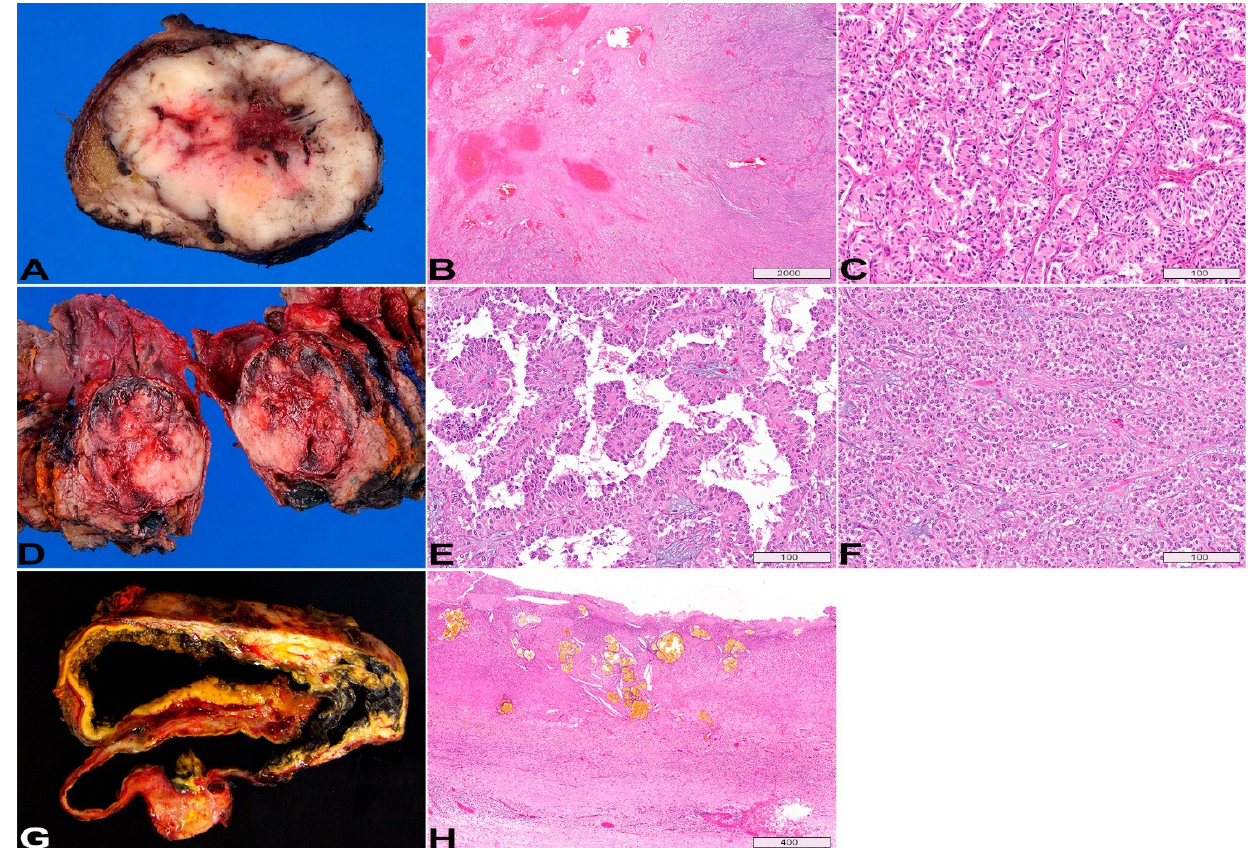
Figure 7. Cystic neuroendocrine tumor (cNET, A – C ), solid pseudopapillary neoplasm (SPN, D – F ), and pseudocyst ( G , H ). ( A ) Gross photo showing an early cNET that has a solid cut surface with central hemorrhage/cystic degeneration. ( B ) Corresponding histology image showing hemorrhage with fibrosis. ( C ) cNET is composed of nests, trabeculae, insular organization of the neoplastic cells, separated by thin vascular fibrous septa. ( D ) Gross photo of the cut surface of a resected SPN, multifocal hemorrhage, necrosis, and cystic degeneration are apparent. ( E ) Pseudopapillary structures due to neoplastic perivascular growth and the degeneration of the tumor cells in between the papillae from lack of blood supply. ( F ) As the name implies, there are also solid areas in SPN, which resembles pancreatic NET on both histology and endomicroscopy. ( G ) Gross photo of the cut surface of a resected pseudocyst that is located in between the pancreatic tail and the spleen. ( H ) A thick fibrotic wall without epithelial lining is seen in this chronic pseudocyst. The cyst wall consists of hematoidin pigment, inflammation, granulation tissue and fibrosis. ( B , C , E , F , H ), H&E stain, original magnification, ( B ), 10 × ; ( C , E , F ), 200 × ; ( H ), 50 × . Scale bars, in µ